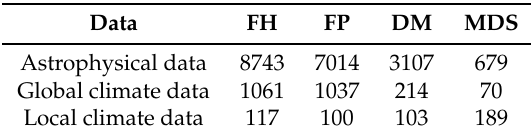
Table 1. Pre-computation times (in seconds) for the visualization approaches used in the examples